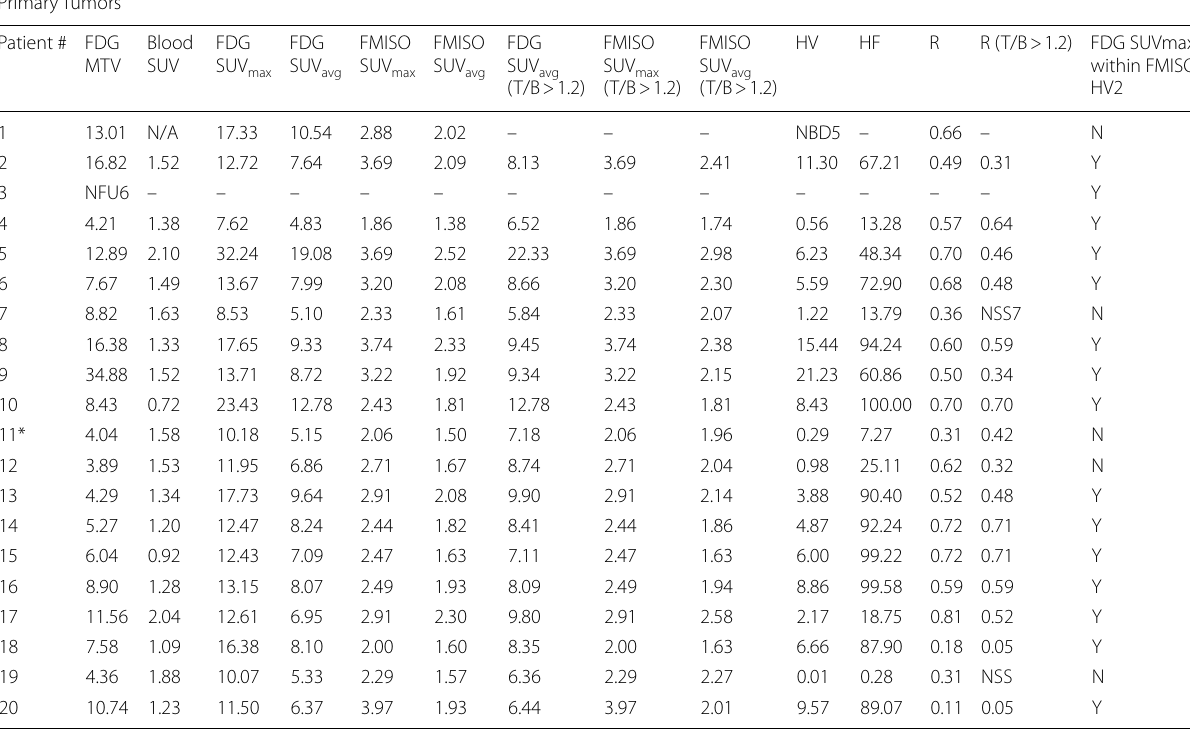
Table 2 Results summary for the primary tumors